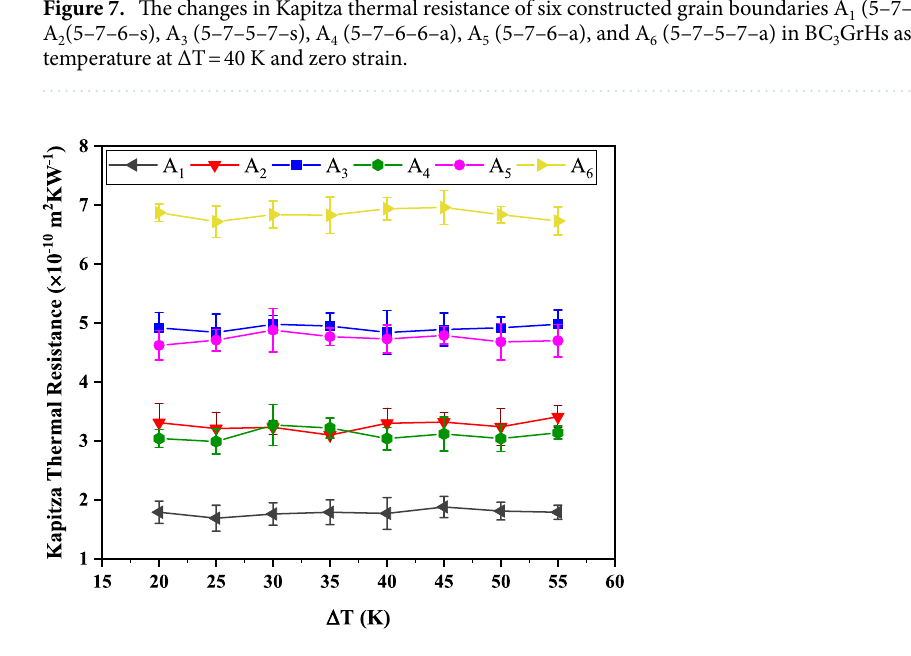
Figure 8. The changes in Kapitza thermal resistance of six constructed grain boundaries A 1 (5–7-6–6-s), A 2 (5–7-6-s),